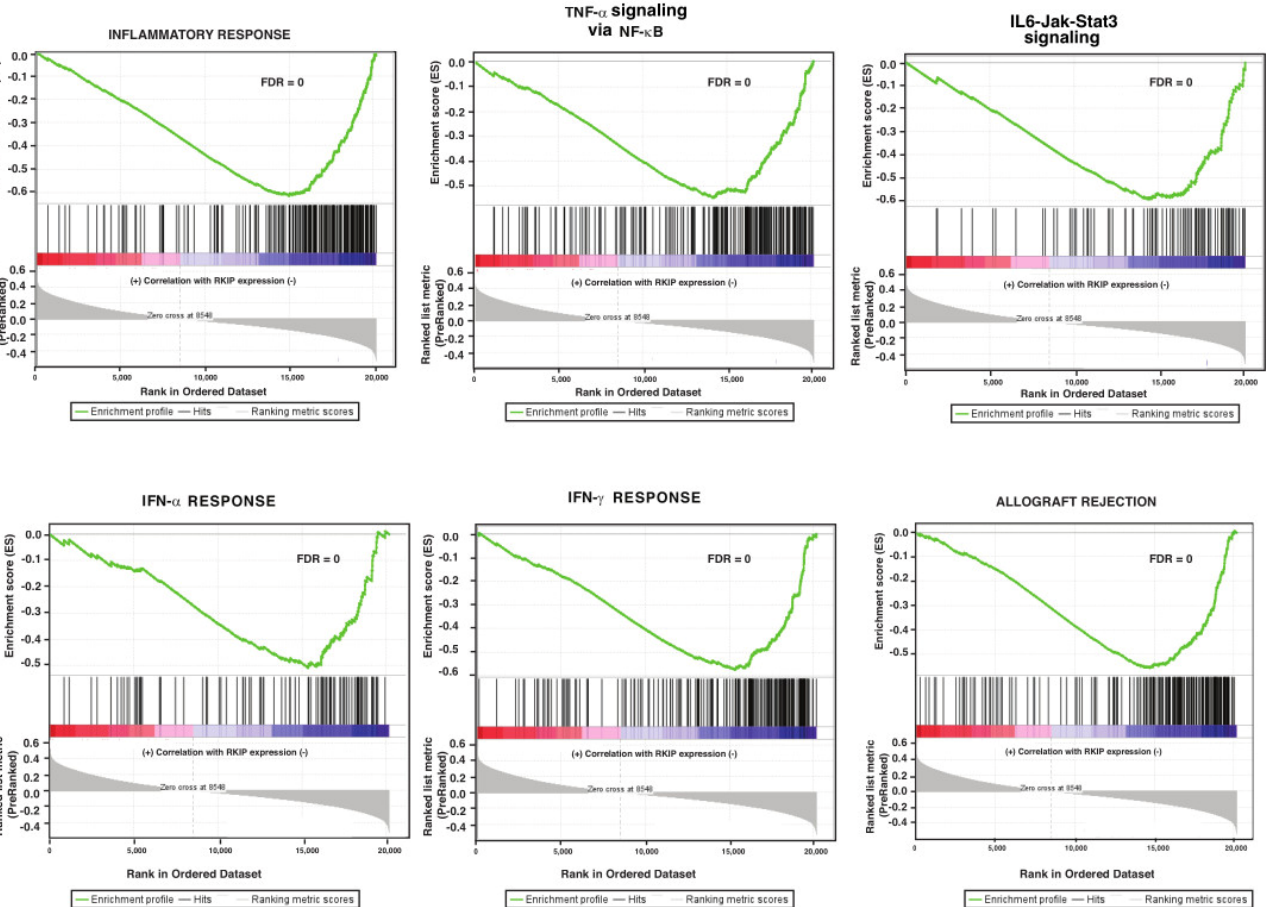
Figure 5. In RKIP low ‐ expressing clinical breast cancer, gene sets for immune response were significantly enriched. Enrichment scores (ES) are displayed on the y ‐ axis. Vertical black lines on the x ‐ axis represent different genes in the gene sets. Each gene was assigned an ES that was calculated as the maximum deviation from zero as it is going down the ranked list. ES represents the degree of over ‐ representation of a gene set at the top or at the bottom of the ranked gene list. The colored band at the bottom represents the degree of correlation of genes with RKIP expression (red for positive and blue for negative correlation). Significance threshold set at FDR < 0.03.